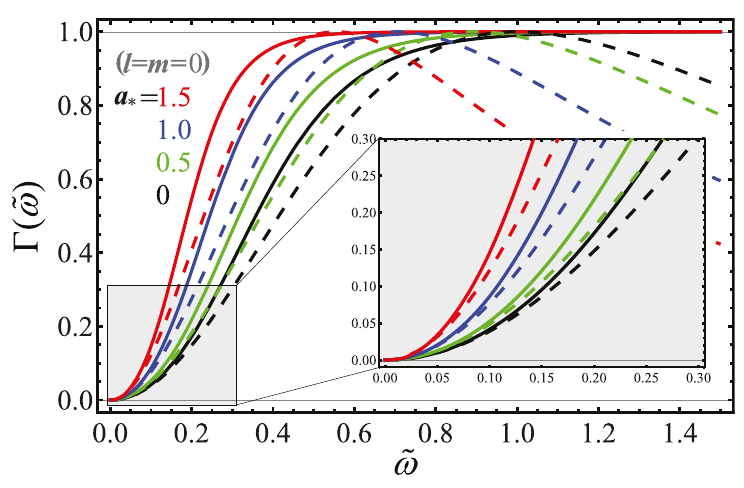
Figure 1 . Greybody factor curves of l = m = 0 modes are compared for various rotation parameters a (cid:3) : solid lines denote the graphes of exact solutions and dashed lines those of approximate solutions in the low frequency limit.